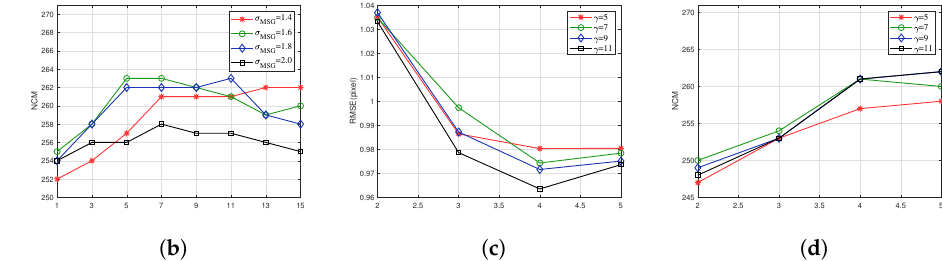
Figure 25. Effects of different parameters on co-registration performance. ( a ) The statistics results of RMSE with different σ MSG . ( b ) The statistics results of NCM with different σ MSG . ( c ) The statistics results of RMSE with different γ MSG . ( d ) The statistics results of NCM with different γ MSG